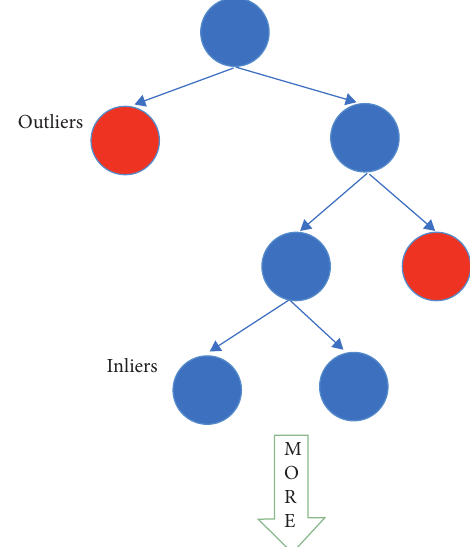
Figure 1: Proposed data mining approach.